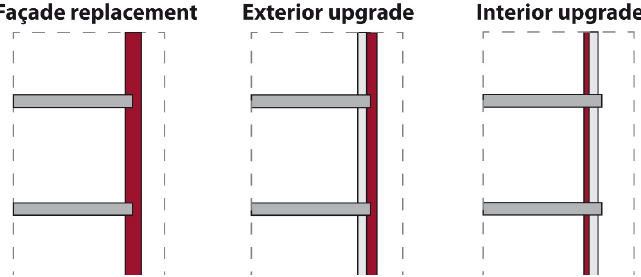
Figure 2. Three façade refurbishment strategies that were compared.